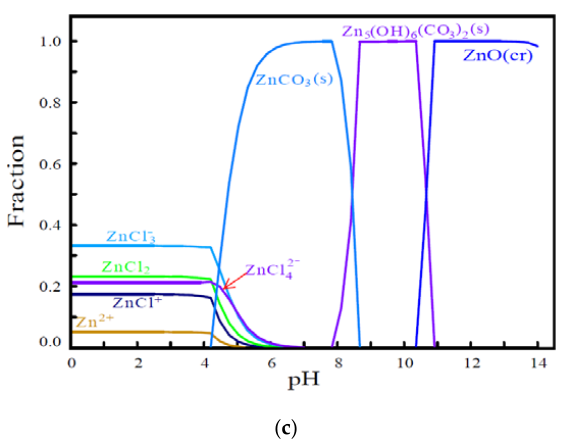
Figure A1. E ff ect of Na 2 CO 3 addition on K + ( a ), Na + ( b ), and Zn 2 + ( c ) phase equilibria in Figure A1. Effect of Na 2 CO 3 addition on K + (a), Na + (b), and Zn 2+ (c) phase equilibria in leaching leaching solution.